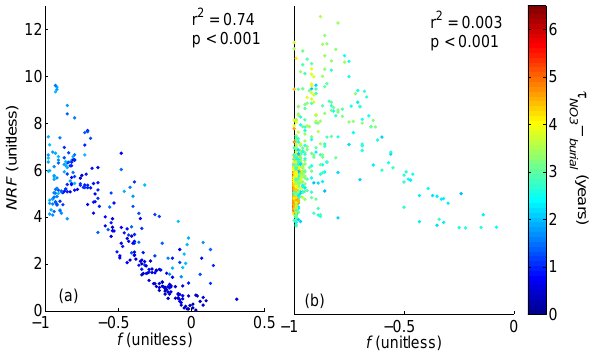
Figure 11. (a, b) Fraction of NO − (negative values) from the snow through photolysis ( f , Eq. 10). (c, d) Modeled enrichment in ice-core δ 15 N(NO − to photolysis-driven loss of NO − scale in (a) and (b) .